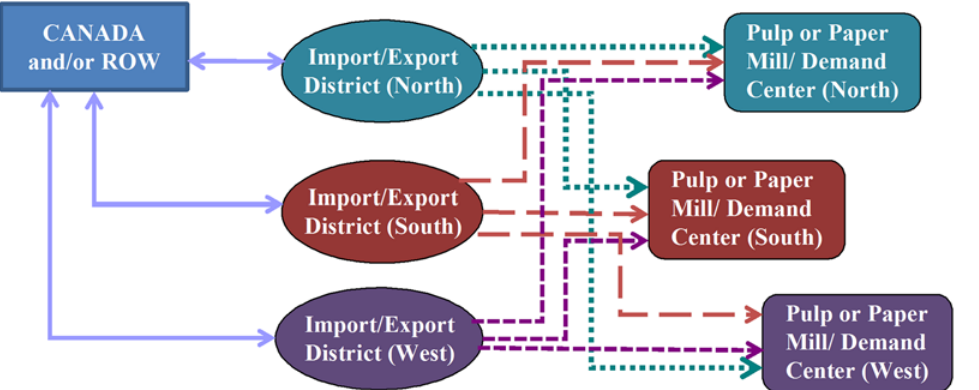
Fig 4. Trade network of pulp and paper products from Canada and/or Rest of the World to pulp/paper mills and demand centers respectively.